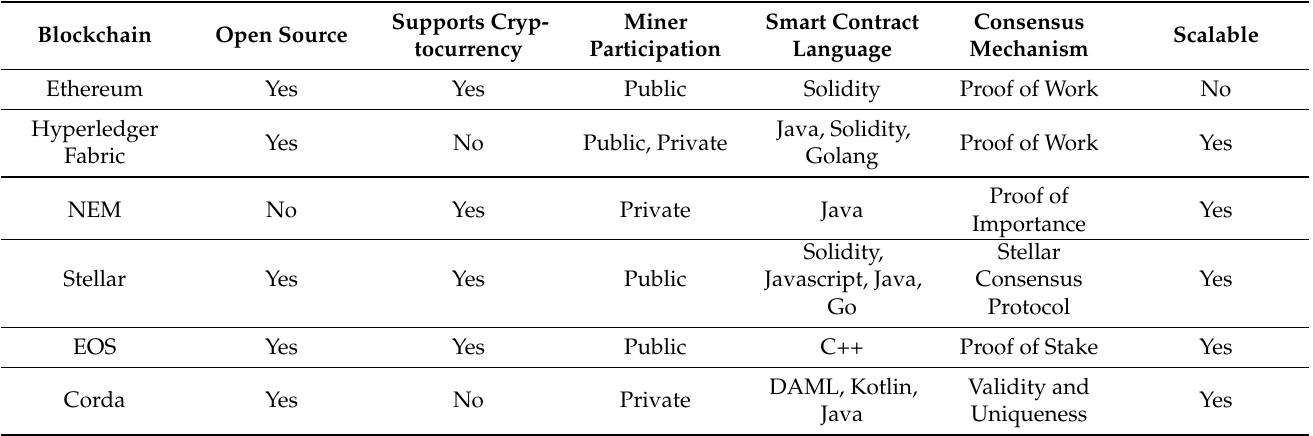
Table 2. Comparison of most used